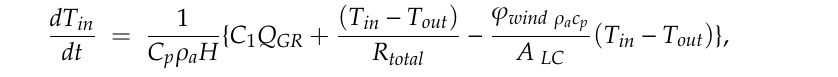
(17) Table A2. Units of the equations.